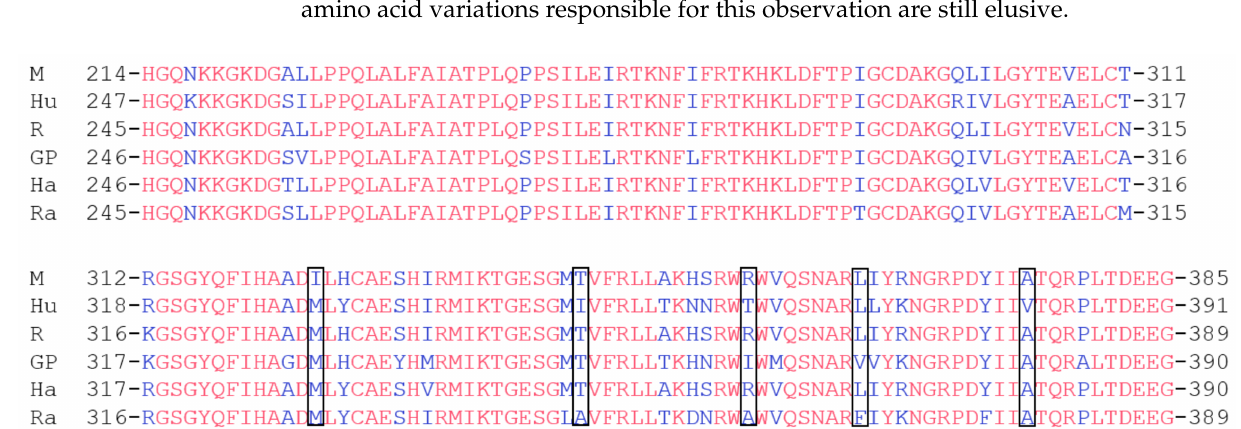
Figure 3. Interspecies multiple sequence alignment of the AhR-LBD. M, mouse; Hu, human; R, rat; GP, guinea pig; Ha, hamster; Ra, rabbit. Some AhR-LBD residues have been characterized by mutagenesis studies and could be responsible for the species-specific AhR response, highlighted in